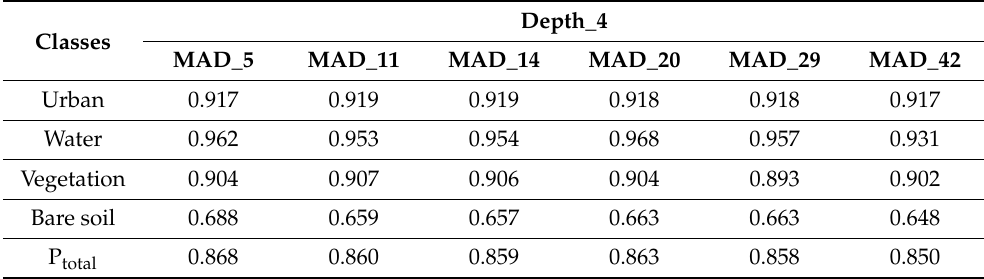
Table 9. Probabilities for classes and total probabilities of correct classification for depth 4 and different MAD.